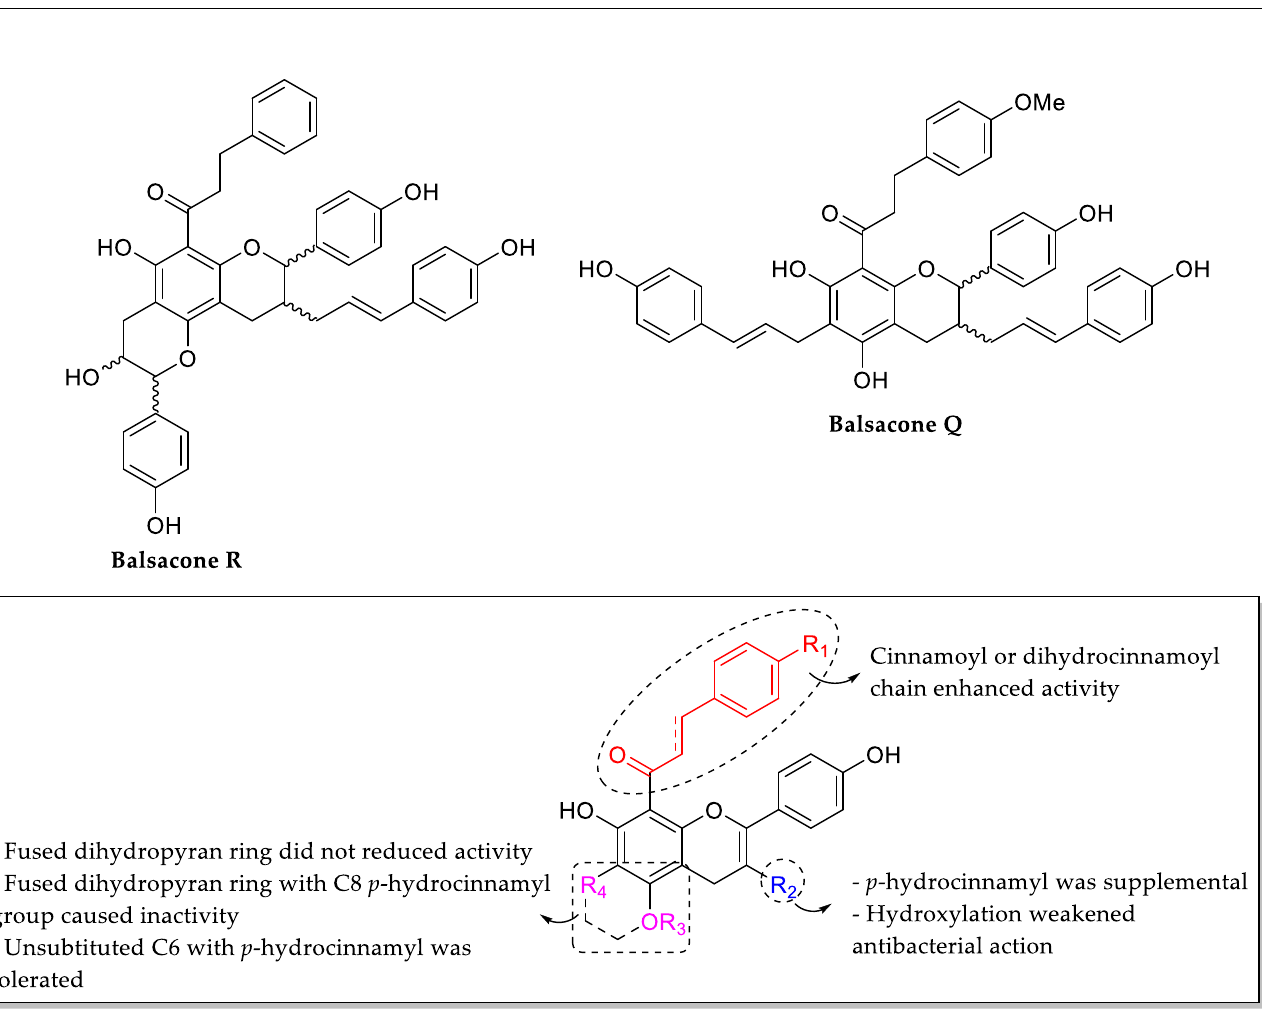
Figure 17. Chemical structures of Balsacone R and Balsacone Q, with the SAR of balsacones for their anti-MRSA activity [83]. Table 10. Anti-MRSA activities of flavonoids isolated from Kenyan plants.